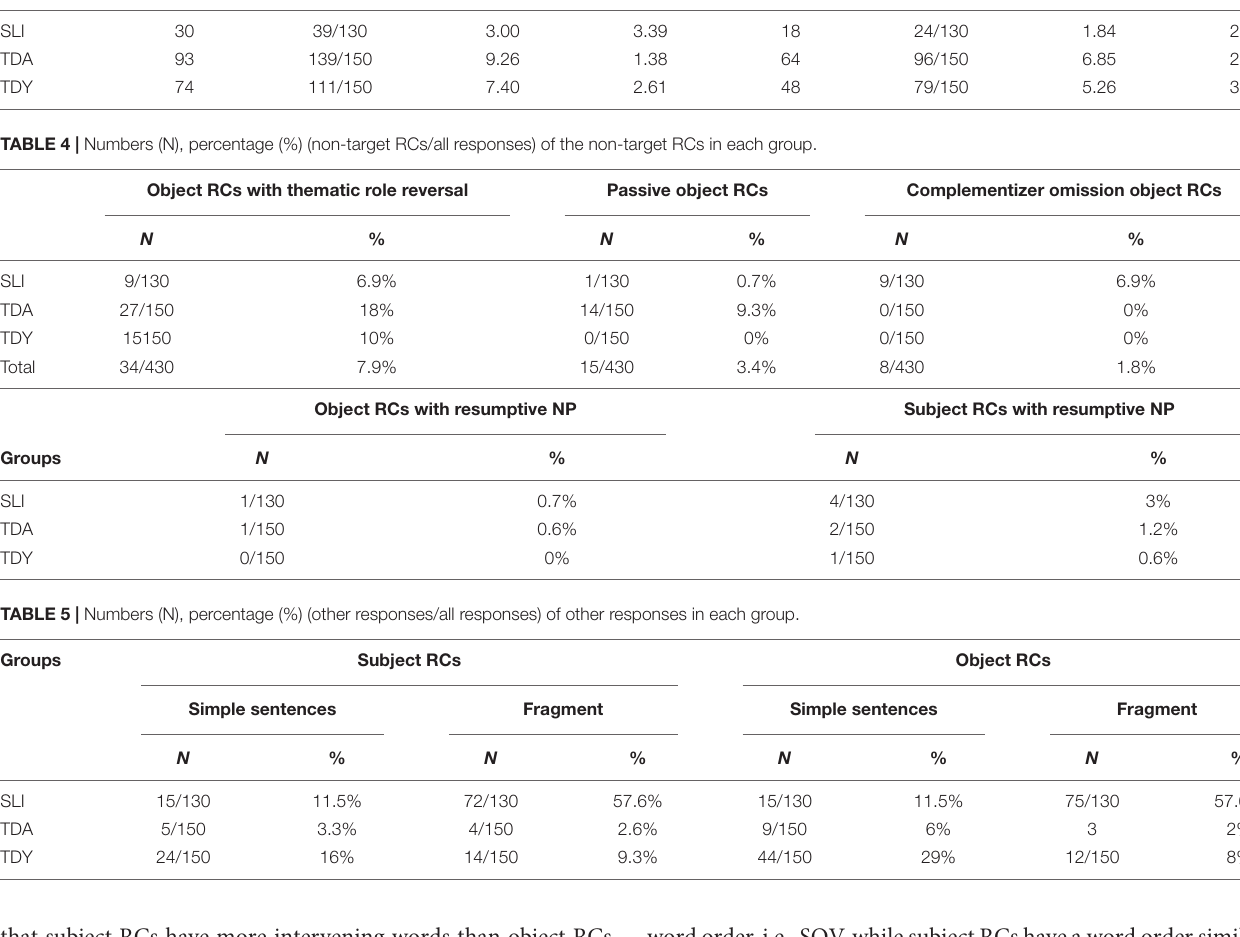
TABLE 3 | Percentage (%), raw scores (N), means (M), and standard deviation (SD) of target responses in each group. Groups